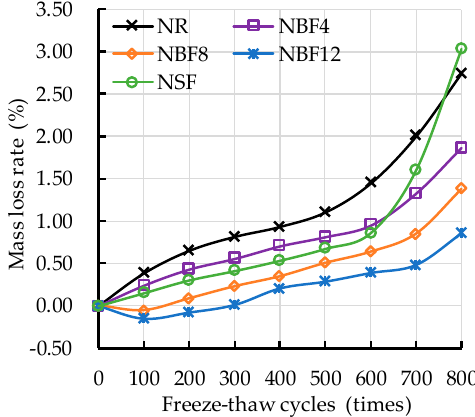
Figure 6. Mass loss rate versus freeze–thaw